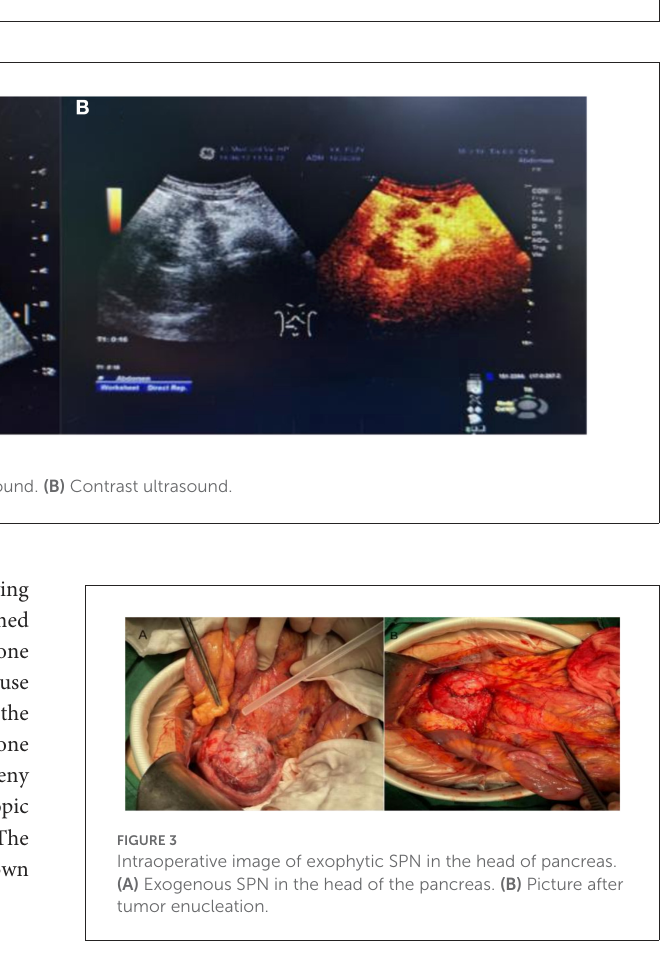
FIGURE1 CT image of an exophytic SPN located in the head of the pancreas. (A) Plain CT scan of the abdomen showed a tumor in the head of the pancreas, showing an exophytic growth. (B) On contrast-enhanced CT, irregular separation can be seen in the cystic part of the cyst, and fibrous component enhancement can be seen in the cyst fluid, showing a “floating cloud sign”. (C) CT images of patients with SPN rupture caused by trauma.